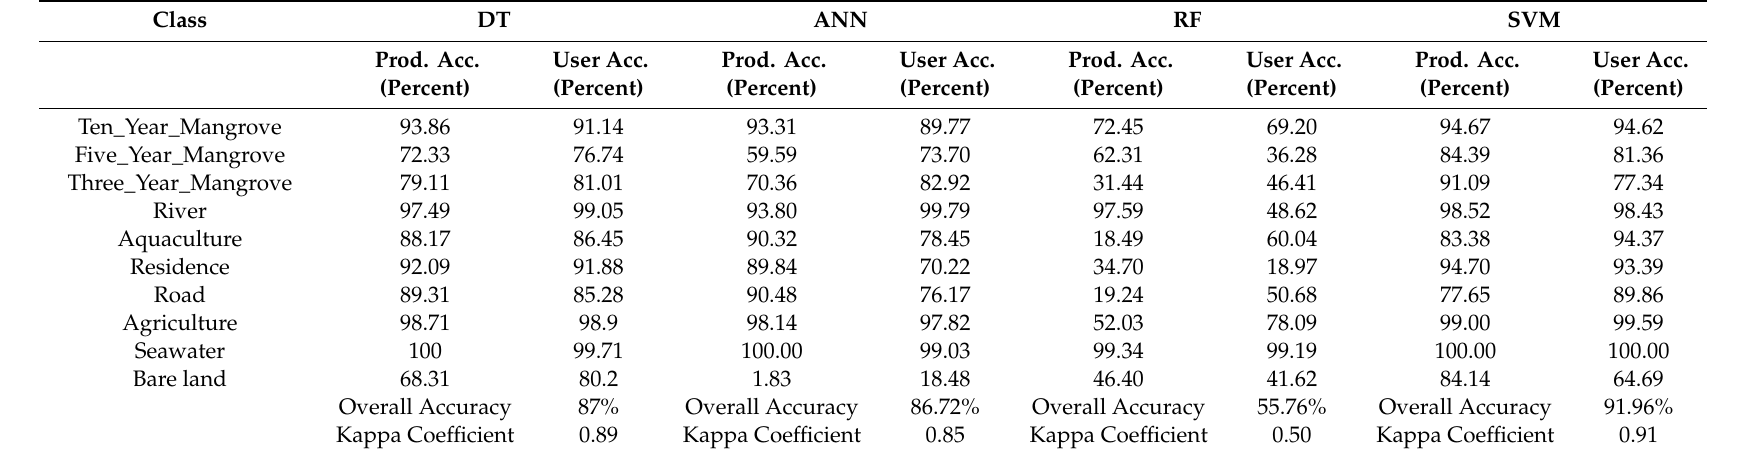
Table 3. Accuracy indexes calculated from confusion matrices for mangrove age classification assessment. Prod. Acc. and User. Acc. are short forms of producer and user accuracy; DT, ANN, RF, and SVM indicate the image classification methods of decision tree, artificial neural network, random forest, and support vector machine,